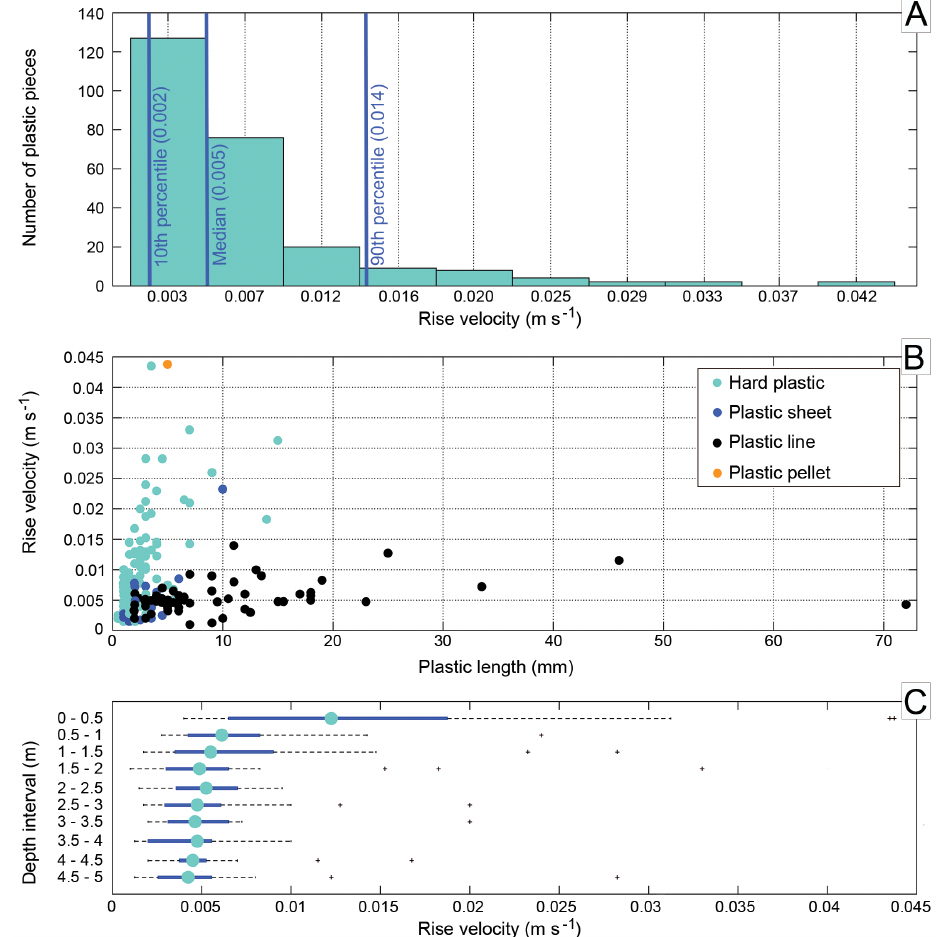
Figure 5. Histogram of rise velocity of plastics (a) , plots of plastic sizes versus rise velocities of different types of plastic (b) , and boxplot of rise velocity for plastics collected at different depth intervals (c) . In panel (c) , the central dot is the median value, edges of the box are the 25th and 75th percentiles, whiskers extend to extreme data points not considered outliers, and outliers are plotted individually as